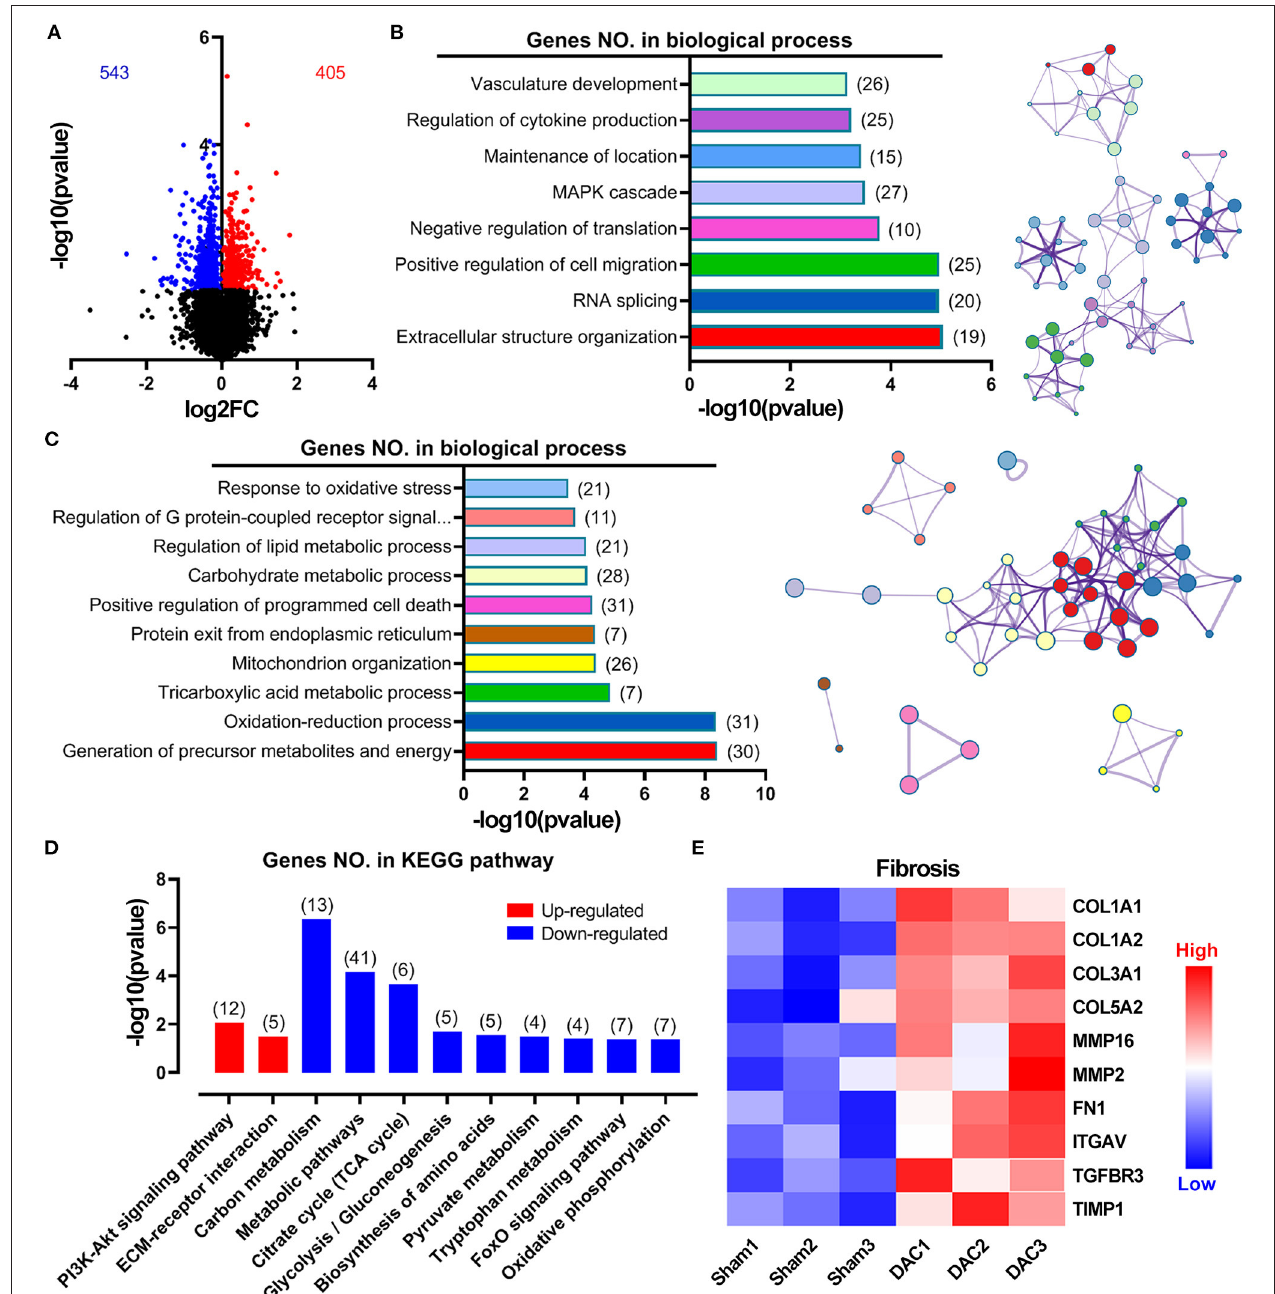
FIGURE 5 | Overall gene expression profiles in sham and DAC animals. Gene enrichment analyses suggested that heart cells in HFpEF suffer inflammatory stress, oxidative stress, remodeling, proliferation, apoptosis, and metabolic disorders. Specifically, 543 genes were downregulated, whereas 405 genes were upregulated in the DAC myocardium compared with that in the sham myocardium (A) . Biological process enrichment analysis identified eight upregulated biological processes (B) and 10 downregulated biological processes (C) . KEGG pathway analysis showed that two pathways were upregulated and night pathways were downregulated (D) . In addition, 10 genes associated with fibrosis were seen in (E) . n = 3 minipigs per group.